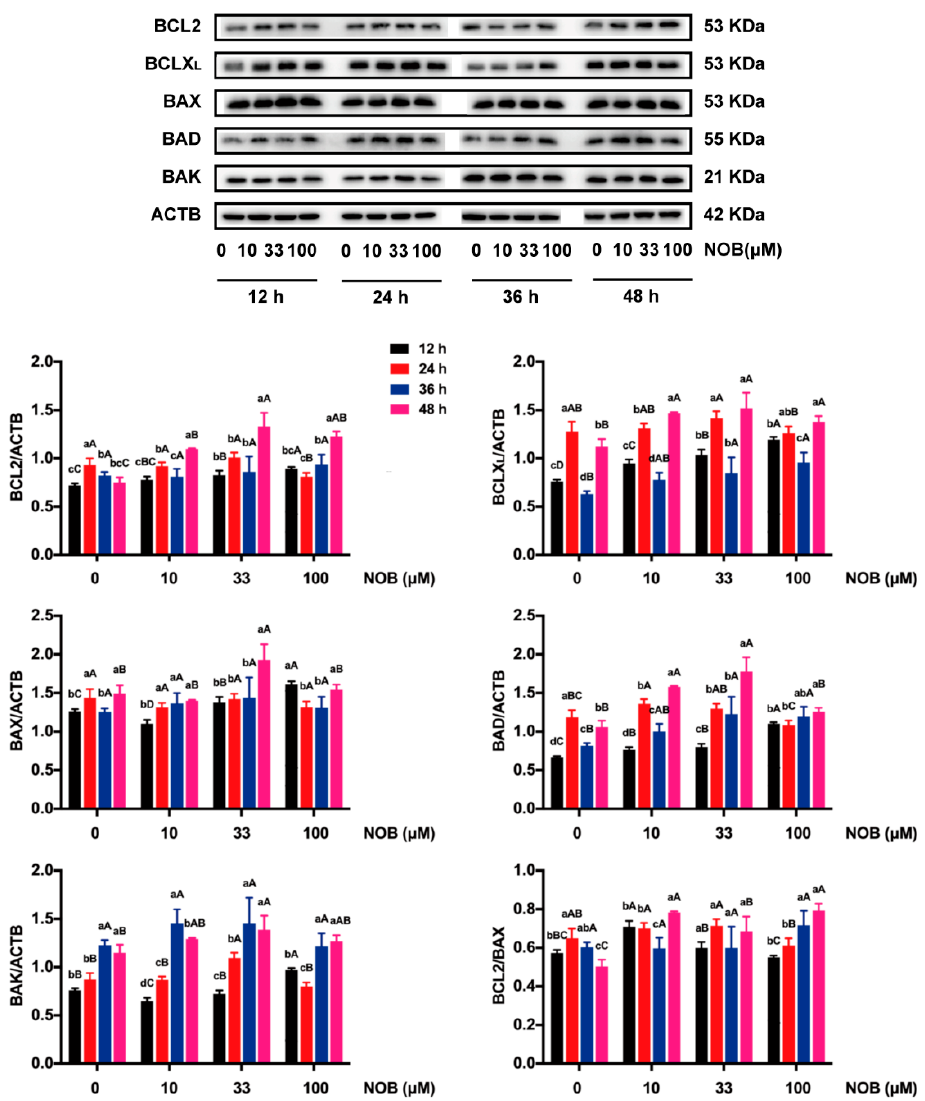
Figure 7. The effect of NOB on expressions of selected members of the B cell lymphoma 2 (BCL2) family genes of BeWo cells. B cell lymphoma 2 (BCL2) family genes in this study included BCL2, BCLX L , BAX, BAD, and BAK. The ratio of BCL2/BAX was calculated. The protein expressions of selected members of the BCL2 family genes were estimated by Western blot. ACTB was used as an internal control, and the relative protein expression was the ratio of target protein to ACTB. Data were summarized as mean ± SD, n = three independent experiments. At the same NOB treatment dose, different lowercase letters represent significant differences at different treatment times, p < 0.05. At the same treatment time, different capital letters represent significant differences at different NOB doses, p < 0.05, one-way ANOVA, using Duncan’s multiple range test.